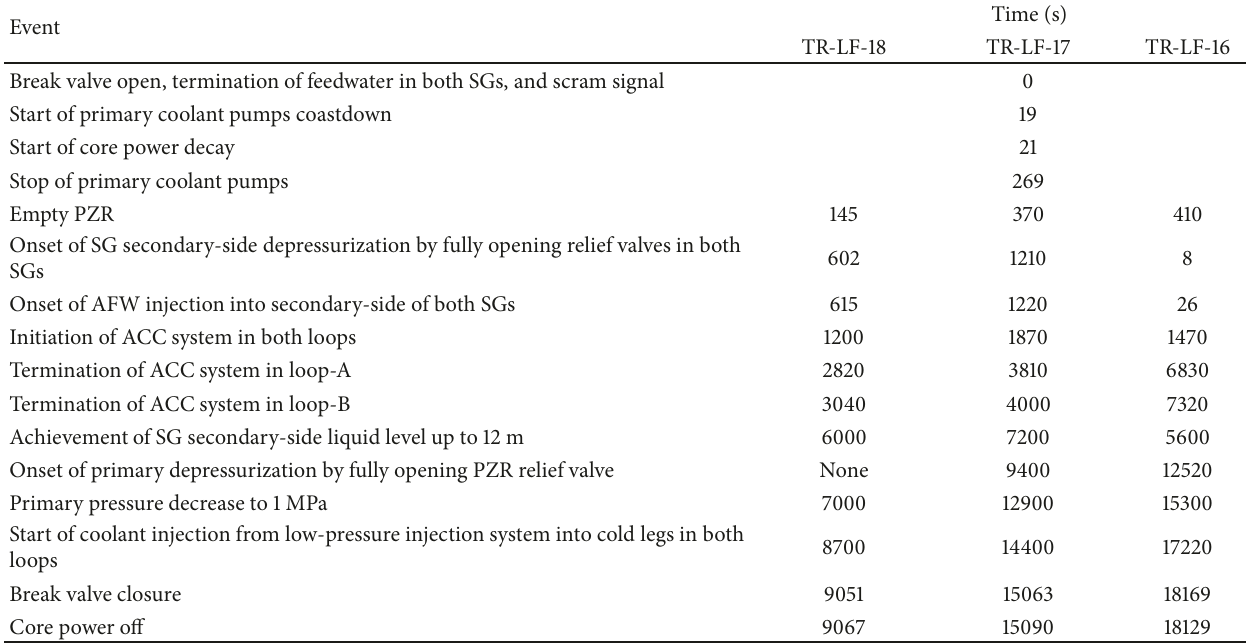
Table 3: Chronology of major events in LSTF tests.